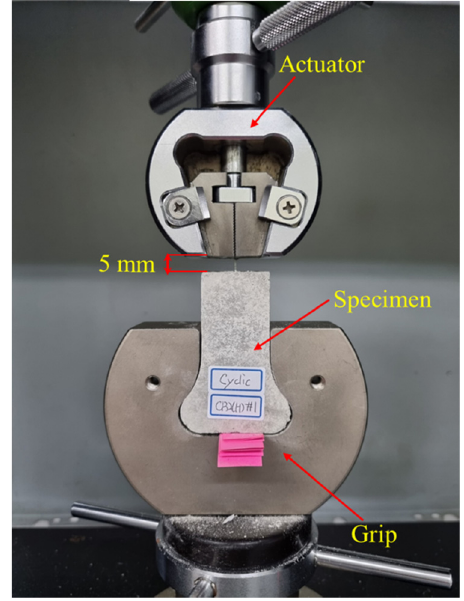
Figure 3: Cyclic pullout test